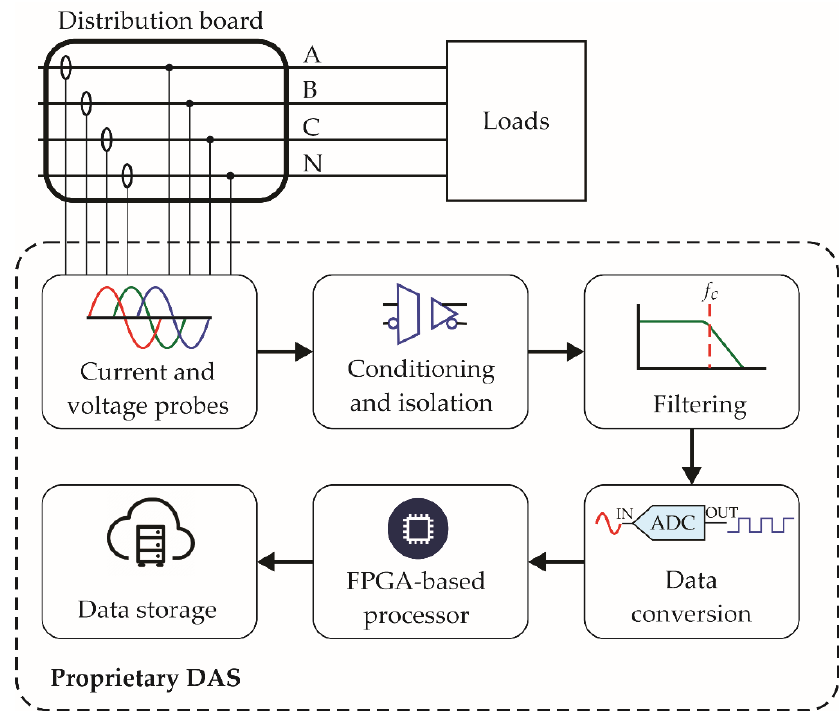
Figure 4. Functional diagram for the DAS.